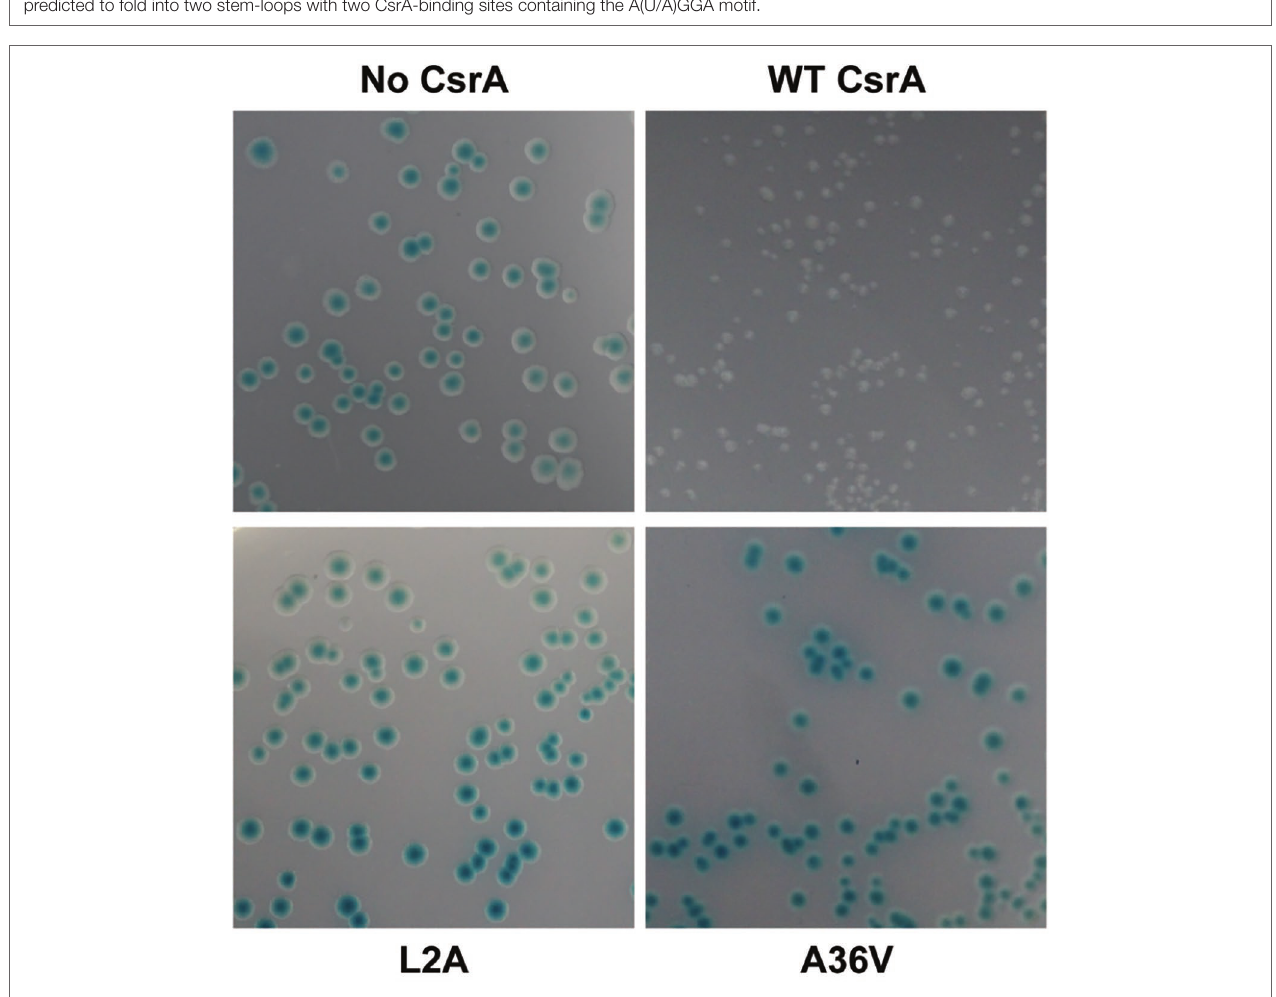
FIGURE 5 | Repression of AstA translational fusion by WT and mutant CsrA proteins. E. coli BL21(DE3) was co-transformed with the translational reporter pJOFE (encoding the flaA 5 ′ UTR translationally linked to astA , under control of the lac promoter) and either: pET-20b (“No CsrA”, top left panel), pET-20b-CsrA (“WT CsrA”, top right panel), pET-20b- CsrA-L2A (“L2A”, bottom left panel), or pET-20b-CsrA-A36V (“A36V”, bottom right panel), and plated on LB plates containing 50 μg/ml of arylsulfatase substrate. The intensity of the blue color of the colonies indicates AstA enzyme activity and lack of CsrA regulatory activity. Experiments were done a minimum of three times, using triplicate